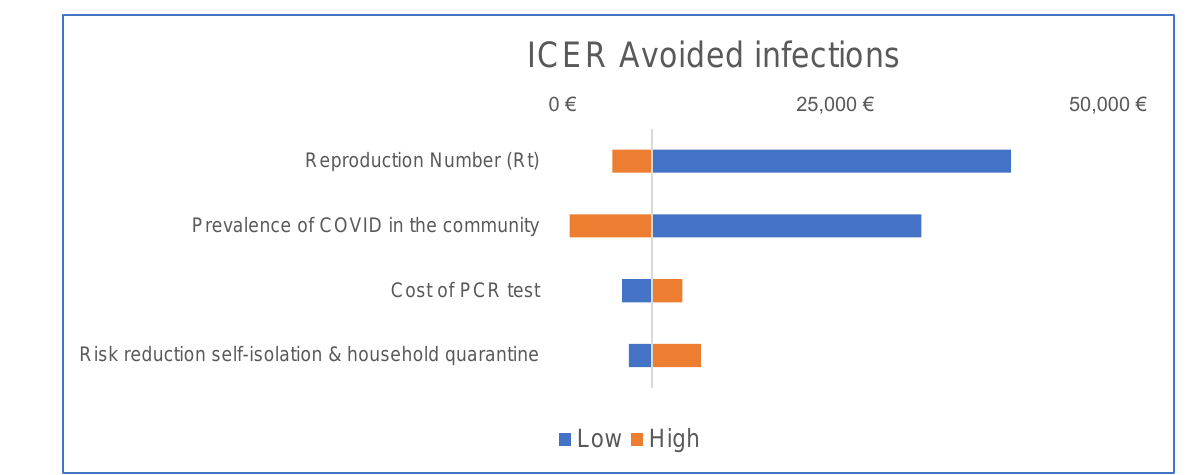
Figure 2. Tornado diagram: primary outcome, RP vs. RP with icolung. For the secondary outcome (avoided hospital days), the model is most sensitive to the prevalence of COVID-19, the prevalence of the omicron (and, indirectly, the delta) variant, the hospitalization rate of the delta variant, the cost of the PCR test, and the risk reduction in both long stay and ICU admission (Figure 3).